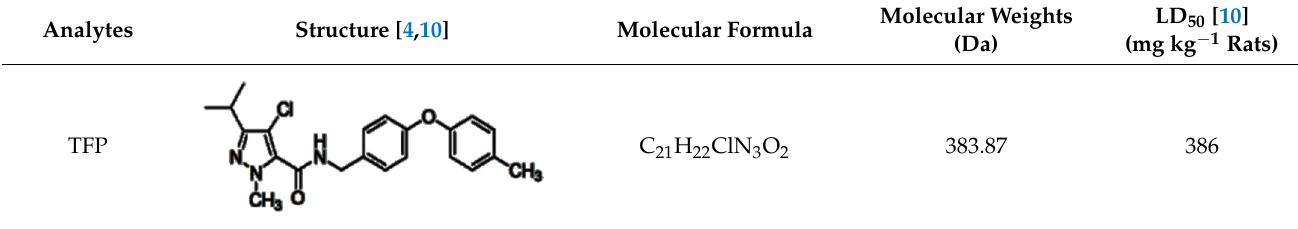
Table 1. The chemical structure and toxicological parameters of TFP and its main metabolites. Analytes